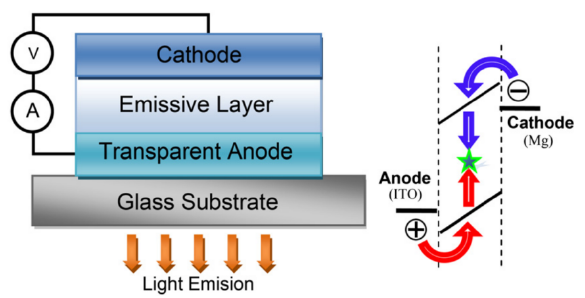
Figure 13. Structure of a single layer OLED based on M29 and M30 . Holes and electrons are recombined in the organic layer that generates light. Cathode was Mg and transparent anode is ITO (adapted from ref. [121]). (adapted from ref.